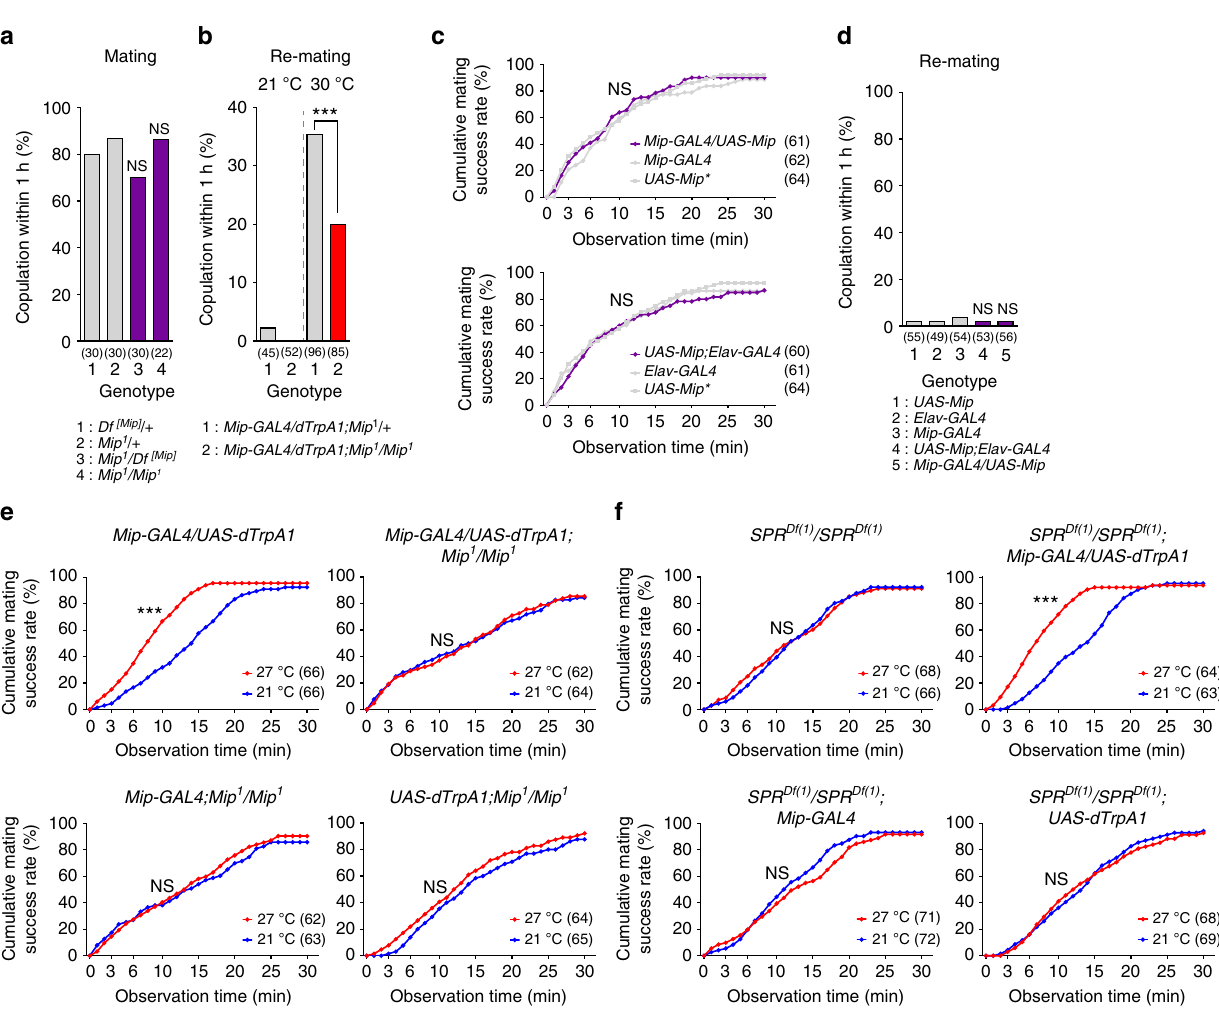
tubulin-FRT-GAL80-FRT ( tub > GAL80 > ) and the heatshock- fl ipase ( hs-FLP ). In this system, a brief exposure to high temperature (37 °C, 35 min) induces FLP expression. FLP then excises GAL80 in a small fraction of Mip-GAL4 neurons per fl y, permitting dTrpA1 and dsRed expression only in the affected cells. We proceeded to count the dsRed/dTrpA1-positive AG neurons in mosaics with and without the re-mating phenotype when they were incubated at 30 °C. Of the fi ve groups of AG Mip neurons, only the vAM neurons show signi fi cantly more dsRed labelling in re-mating mosaics than in non-re-mating mosaics